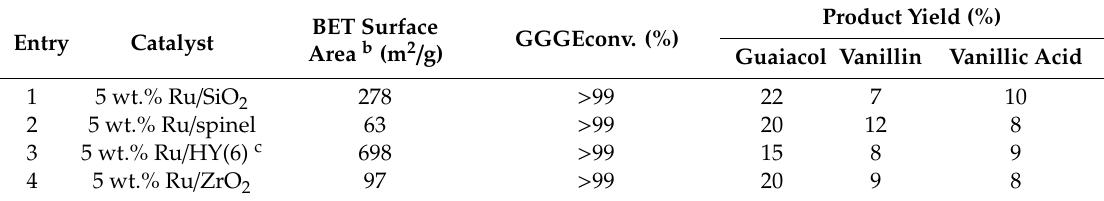
Table 2. Catalytic oxidation of GGGE with alternative Ru / support catalysts a